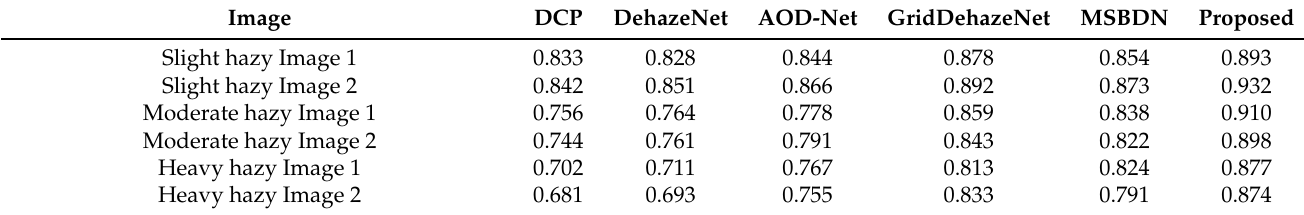
Table 7. Experimental results on different images: